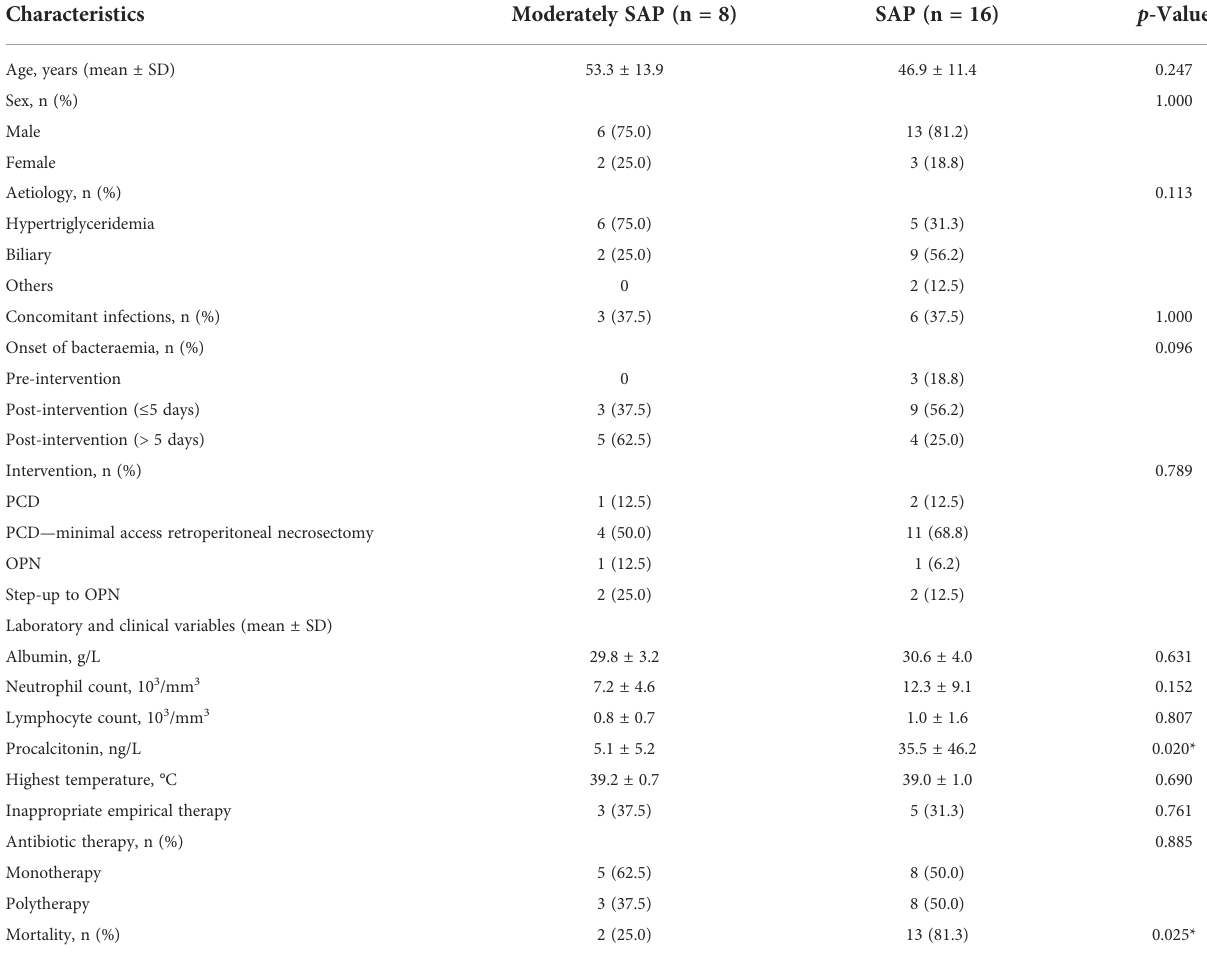
TABLE 2 Clinical characteristics and comparison between different categories among 24 IPN patients with MDR-GNB bacteraemia.